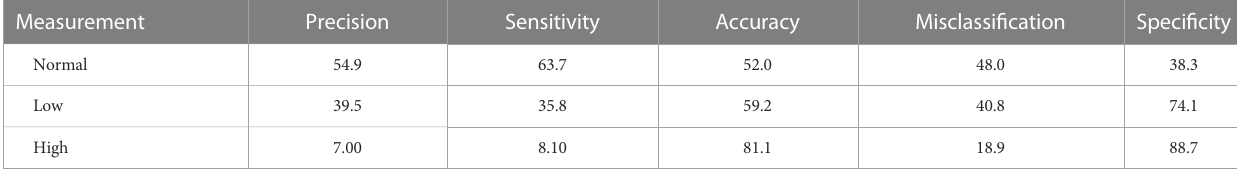
TABLE 4 Confusion matrix metrics summary for heart rate data obtained from a sensor classi fi ed into categorical responses re fl ecting “ Normal ” , “ Low ” , and “ High ” heart rates 1 . Measurement Precision Sensitivity Accuracy Misclassi fi cation